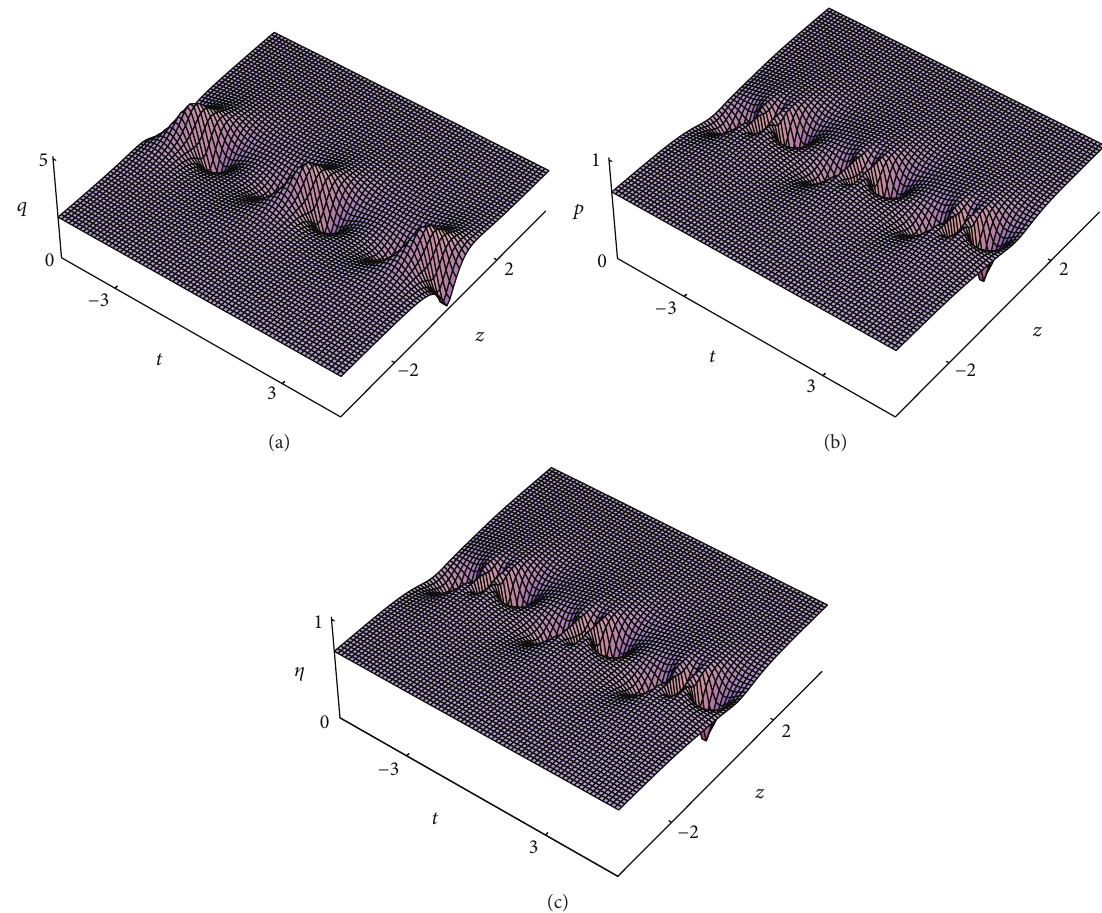
Figure 3: The parameters adopted here are 𝜅 𝑠 = 1.3 , 𝑞 𝑐 = 1 , 𝜅 𝑐 = 3 , 𝜔 = 1 , and 𝜏 = 0.1 .